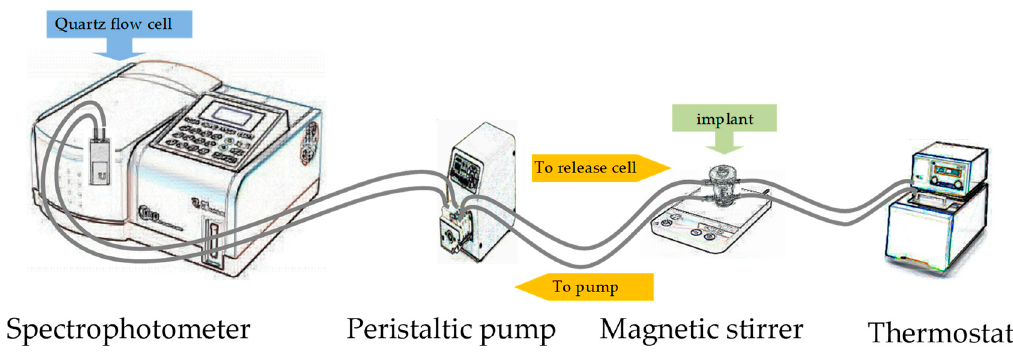
Figure 1. A schematic representation for the release apparatus.